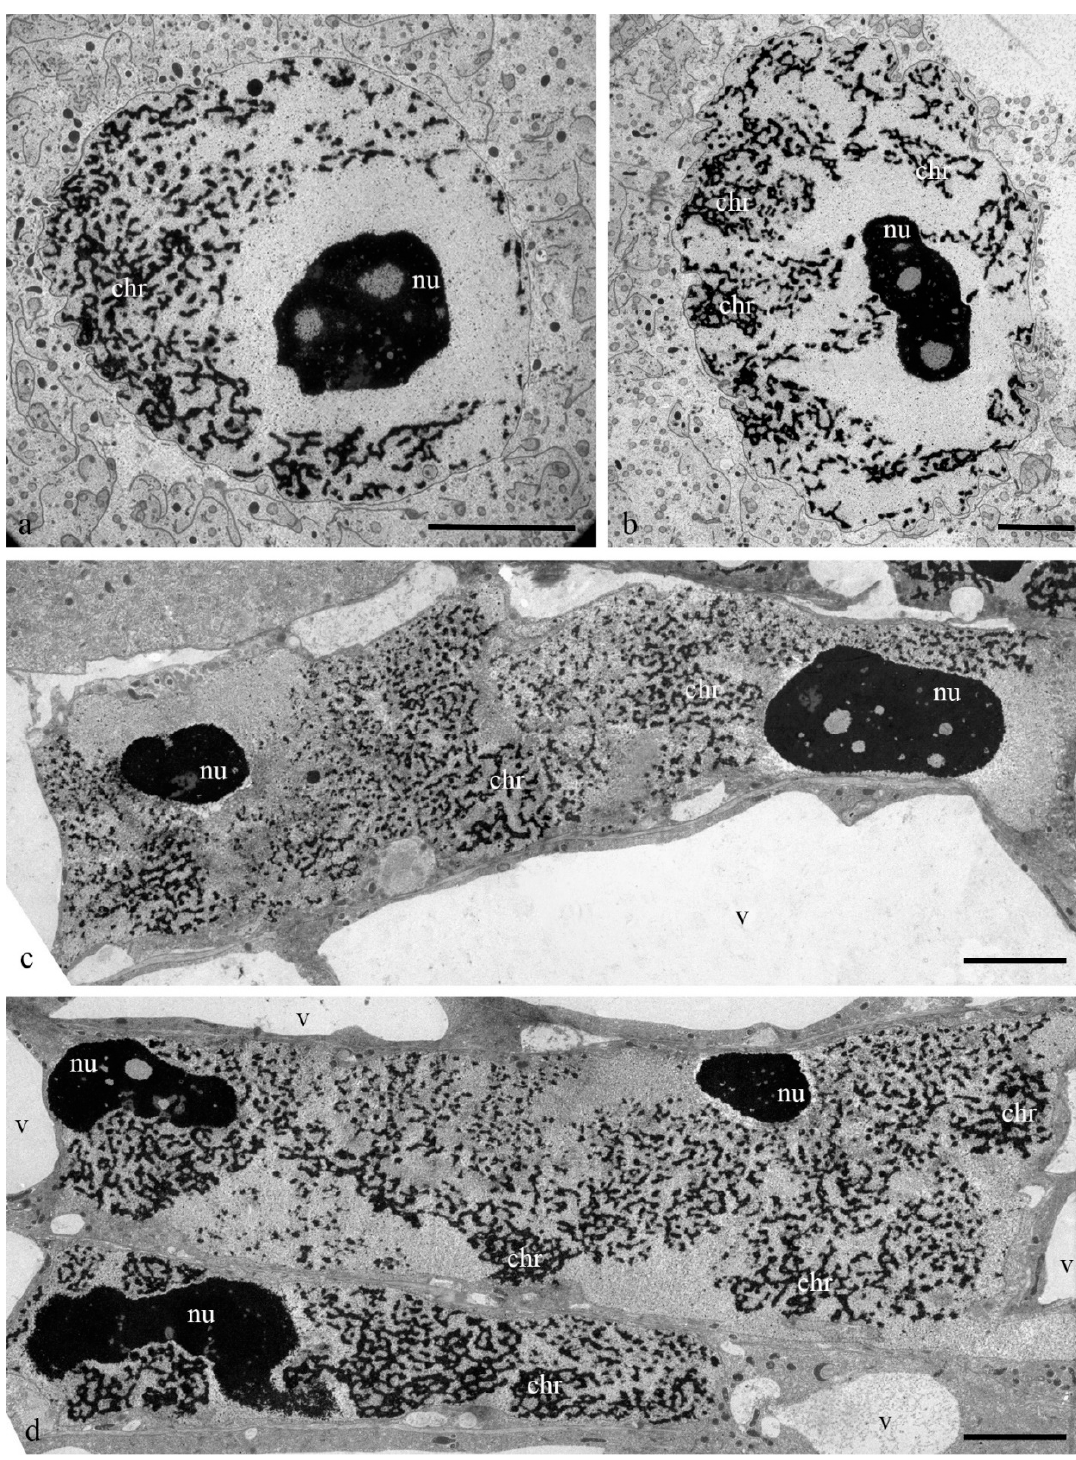
Figure 3. Ultrastructure of the nuclei of the antipodal cells of wheat embryo sacs at various stages of differentiation. Round nuclei of antipodal cells at the early stage of differentiation ( a , b ); elongated nuclei of antipodal cells at the middle ( c ) and late stages of differentiation ( d ). chr—polytene chromosomes; nu—nucleolus; v—vacuoles. The scale is 10 µ